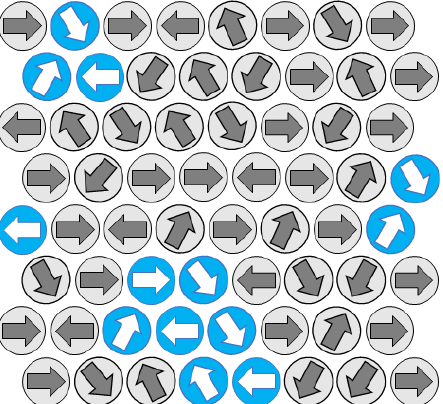
Figure 1. Attempts of movement in the DLL algorithm. Successful ones are marked as empty arrows in blue. A 2D case with Z = 6 is shown for